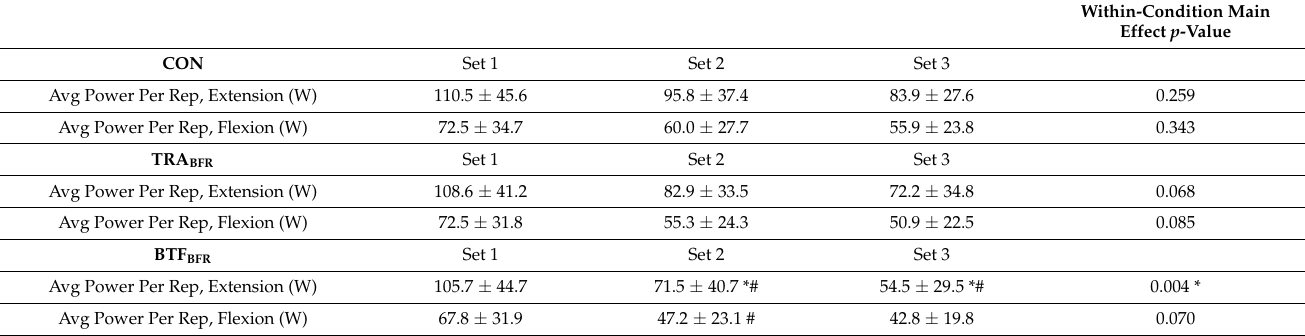
Table 4. Changes in average power per repetition during each of the three exercise sets (M ±